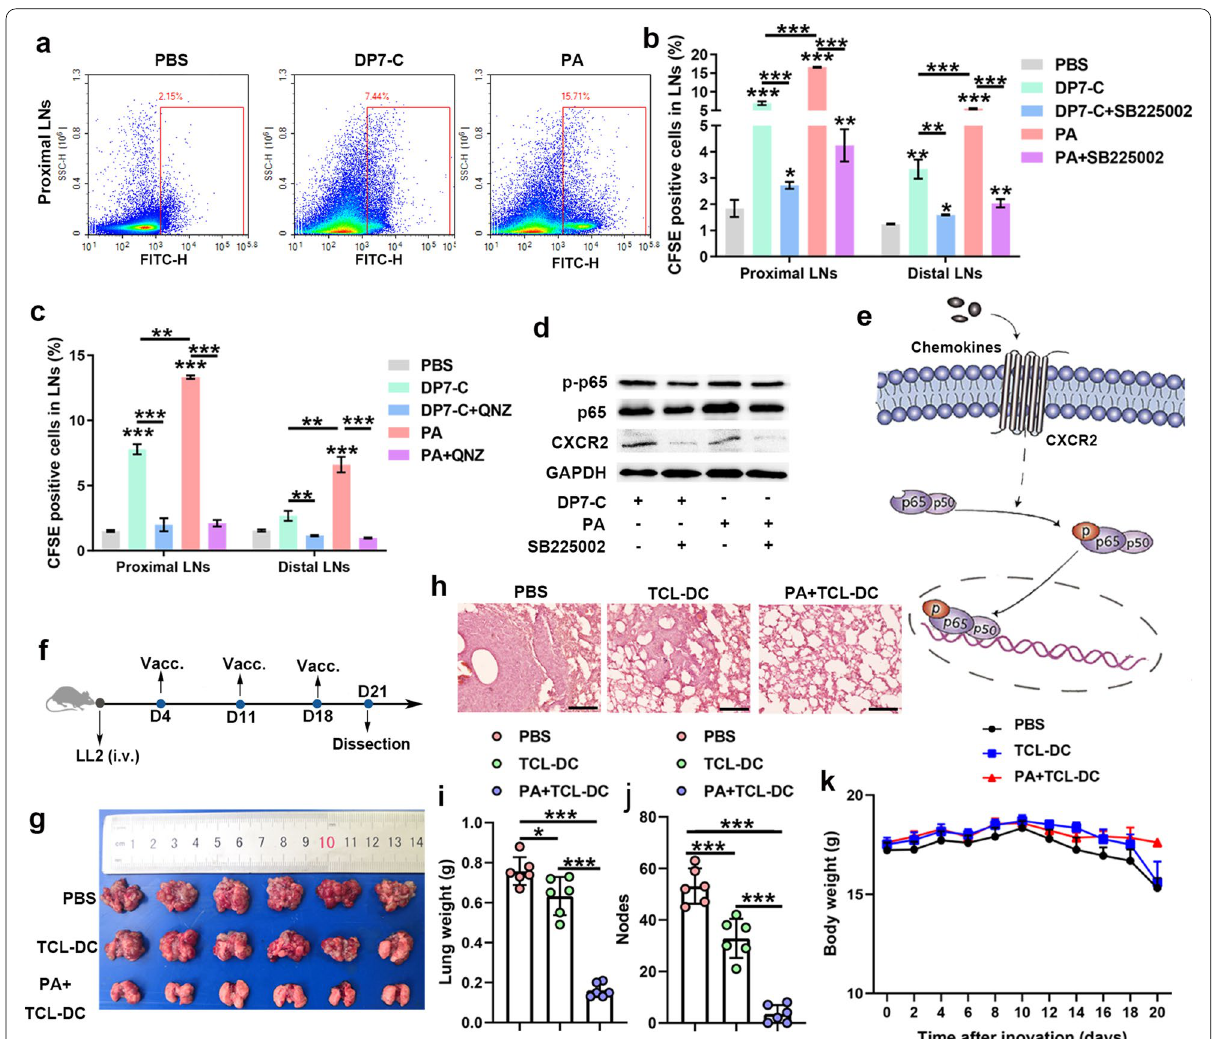
Fig. 7 DP7-C and PA enhance the effect of DC vaccines by promoting DC migration to LNs. a . The histogram of the flow cytometry results showing that PA enhances the LNs homing of CFDA-SE labeled DC in vivo. b . Preadministration of an inhibitor of CXCR2 in vivo decreased the efficiency of DP7-C- and PA-mediated LN homing in DCs ( n 3). c . Preadministration of an inhibitor of NF-κB in vivo inhibited the efficiency of DP7-C- and = PA-mediated LN homing in DCs ( n 3). d‑e . Western blotting revealed that pretreatment of cells with a CXCR2 inhibitor can inhibit the expression = of NF-κB p65 and p-p65. f . Diagram of the vaccine workflow. g . Representative results of metastatic lung nodules. h . HE staining results of lung tissue in each group. Scale bars, 50 μm. i . Lung weight in each group. j . Number of pulmonary nodules in each group. k . Mouse body weight changes during treatment in each group. Significance was calculated using a one-way ANOVA with multiple comparisons tests (* p < 0.05, ** p < 0.01, *** p <